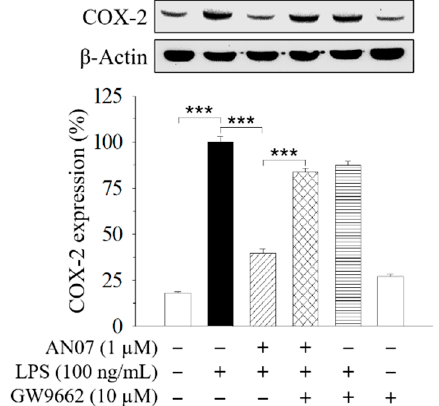
Figure 4. The inhibitory e ff ects of AN07 on COX-2 expressions were attenuated by a selective PPAR γ antagonist GW9662. RAW 264.7 cells were pre-treated with AN07 (1.0 µ M) and / or GW9662 (10 µ M) for 1 h and then exposed to LPS (100 ng / mL) for another 24 h. Upper panels, representative immunoblots. Lower panels, densitometry analyses of the relative ratio of protein / β -actin protein, represented as percentages of the LPS group. Columns, mean ± S.E.M. from at least three independent experiments. *** p < 0.001.